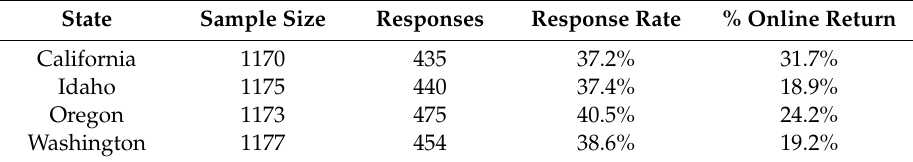
Table 1. Survey Response Rates.